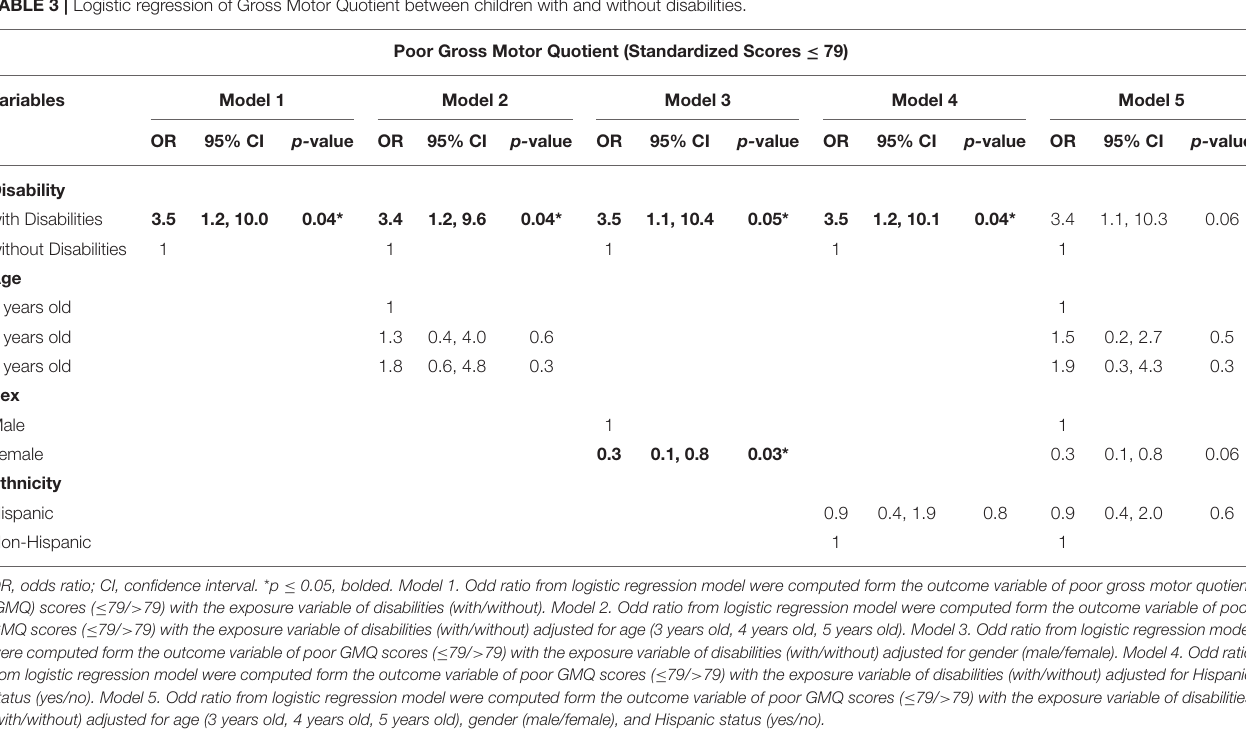
demographics (i.e., sex, age, race/ethnicity) between groups ( p > 0.05; see Table 1